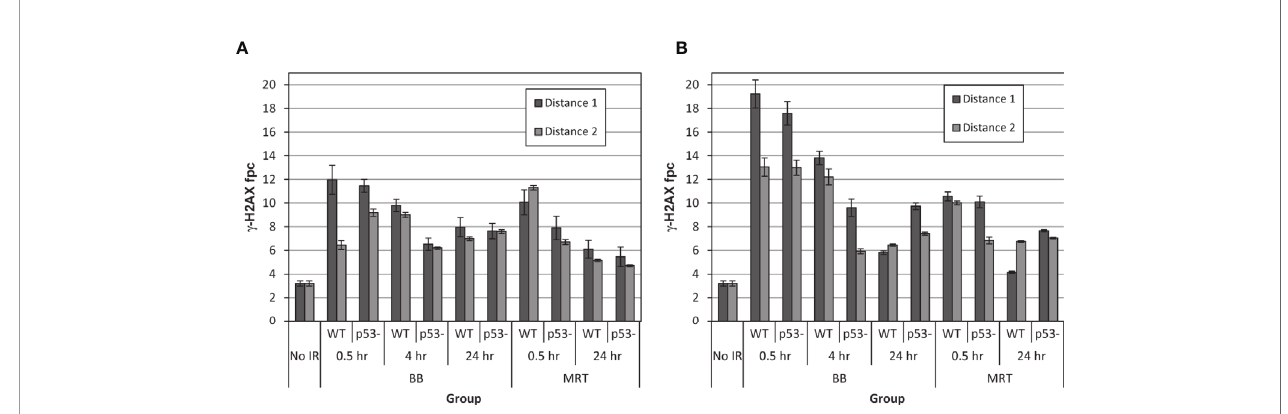
FIGURE 2 | Mean numbers of g -H2AX fpc induced in well 1 (A) and well 2 (B) following irradiation of the targeted fi eld with 40-Gy synchrotron BB and MRT pulse in p53-WT and p53-null HCT-116 cells, at two distances from the irradiated fi eld. An 8x8 mm zone of well 2 was irradiated, therefore the non-targeted cells in well 2 were exposed to factors emitted by the irradiated cells. Well 1 was physically separated from the irradiated fi eld in well 2, therefore the cells in well 1were not exposed to the factors emitted by irradiated cells. After irradiation, the cells were fi xed at noted times and processed for immunostaining. The values are the mean number of foci per cell ± standard error calculated from inter image